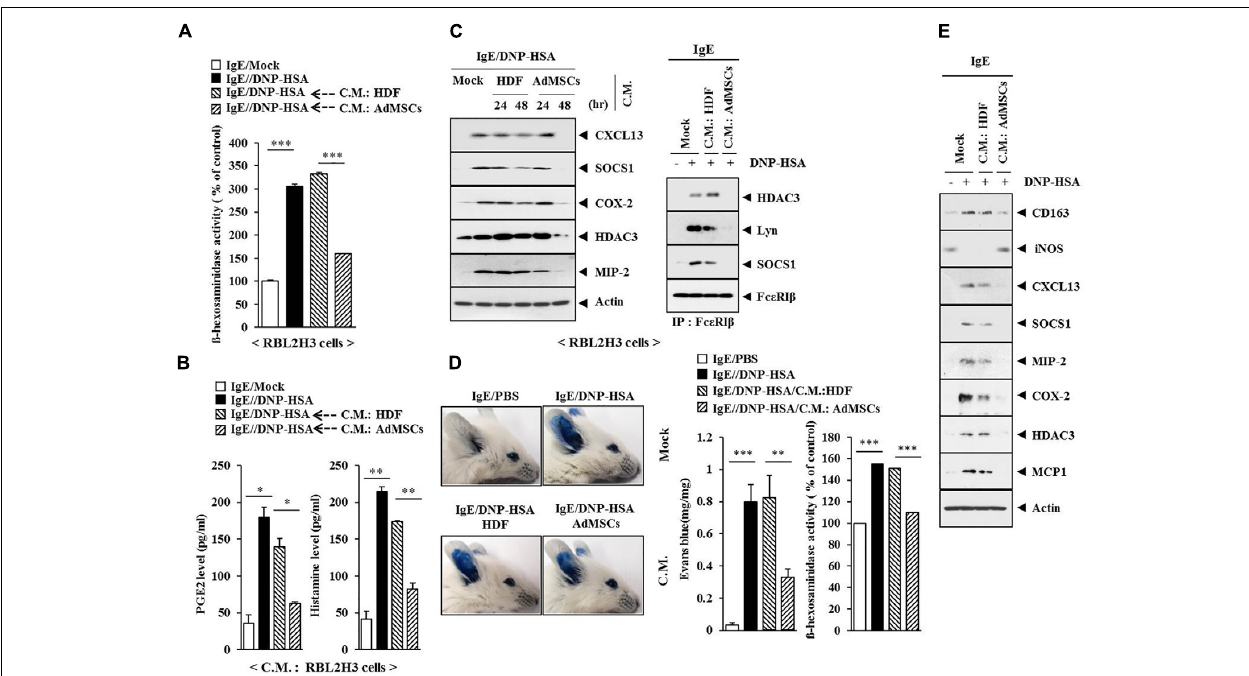
FIGURE 15 | The conditioned medium of AdMSCs inhibits the features of allergic inflammation. (A) The IgE (100 ng/ml)-sensitized RBL2H3 cells were treated without or with the conditioned medium of HDFs or AdMSCs for 48 h, followed by stimulation with DNP-HSA (100 ng/ml) for 1 h. The ß-hexosaminidase activity assays were performed. ∗∗∗ p < 0.0005. (B) Same as (A) except that PGE2 level and the amount of histamine released were determined by using the conditioned medium of RBL2H3 cells. ∗ p < 0.05; ∗∗ p < 0.005. (C) The IgE (100 ng/ml)-sensitized RBL2H3 cells were treated without or with the conditioned medium of HDFs or AdMSCs for the indicated time, followed by stimulation with DNP-HSA (100 ng/ml) for 1 h. Western blot was performed. For immunoprecipitation, lysates from RBL2H3 cells treated without or with conditioned medium for 48 h were employed. (D) BALB/c mice were given an intradermal injection of IgE (0.5 µ g/kg) and intravenous injection of the conditioned medium of HDFs or AdMSCs (each at 200 µ l/mouse). Representative images from four animals of each experimental group are shown. Ear tissue lysates from BALB/c mouse of each experimental group were subjected to β -hexosaminidase activity assays. ∗∗ p < 0.005; ∗∗∗ p < 0.0005. (E) Ear tissue lysates were subjected to western blot